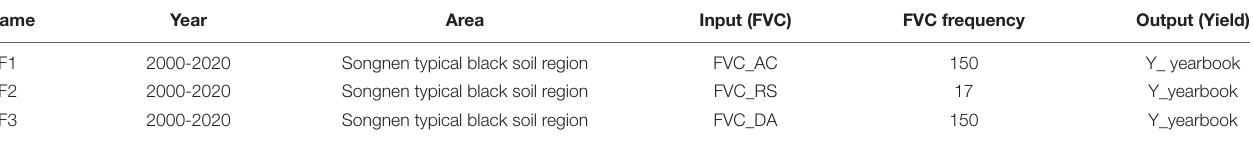
TABLE 5 | Data composition of the random forest